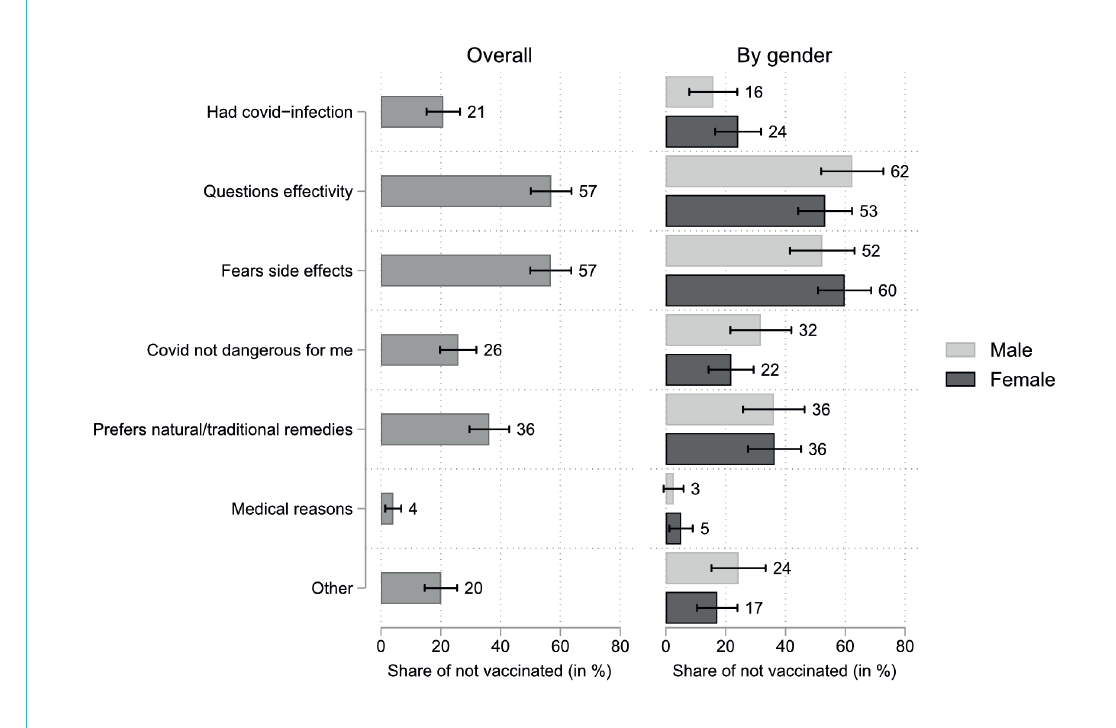
Figure 2: Stated reasons for not being vaccinated at the end of study period overall and by gender. Multiple responses possible. n = 227 (94 males, 133 females), cases weighted to correct for sampling and